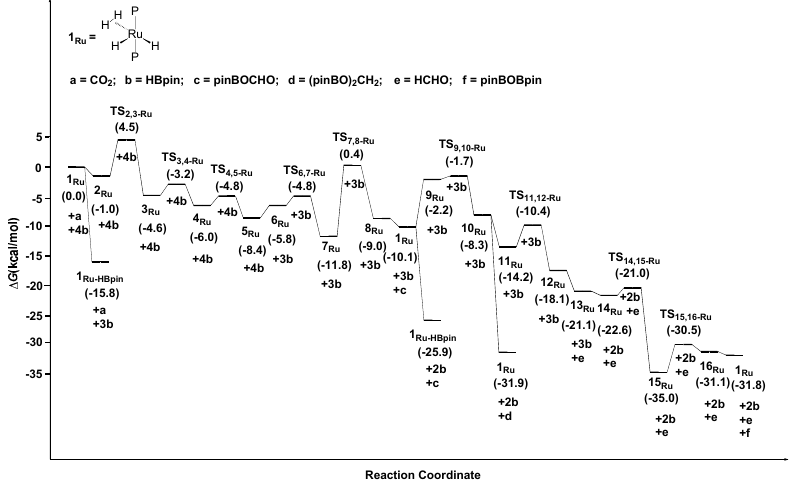
Figure 1. Free energies profile of the reduction of carbon dioxide to formaldehyde catalyzed by 1 Ru .